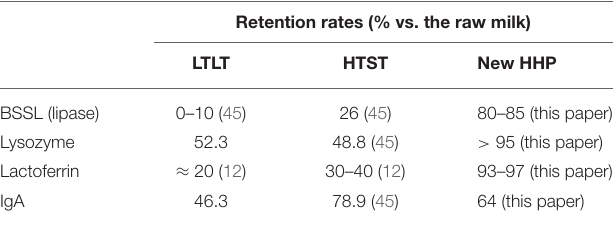
TABLE 5 | Average retention rates of biological activity for different components with specific properties after “Low-temperature, long-time” (LTLT), “High-temperature, short-time” (HTST) and the new “High Hydrostatic Pressure” (HHP) treatments were applied to human milk. Retention rates (% vs. the raw milk) LTLT